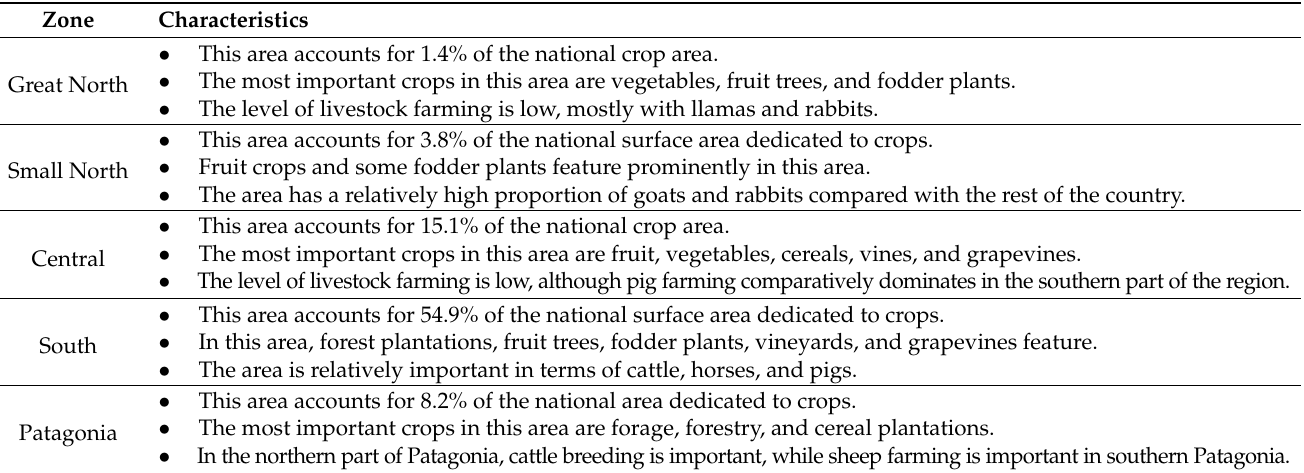
Table 1. Main agrarian characteristic of macro-areas.